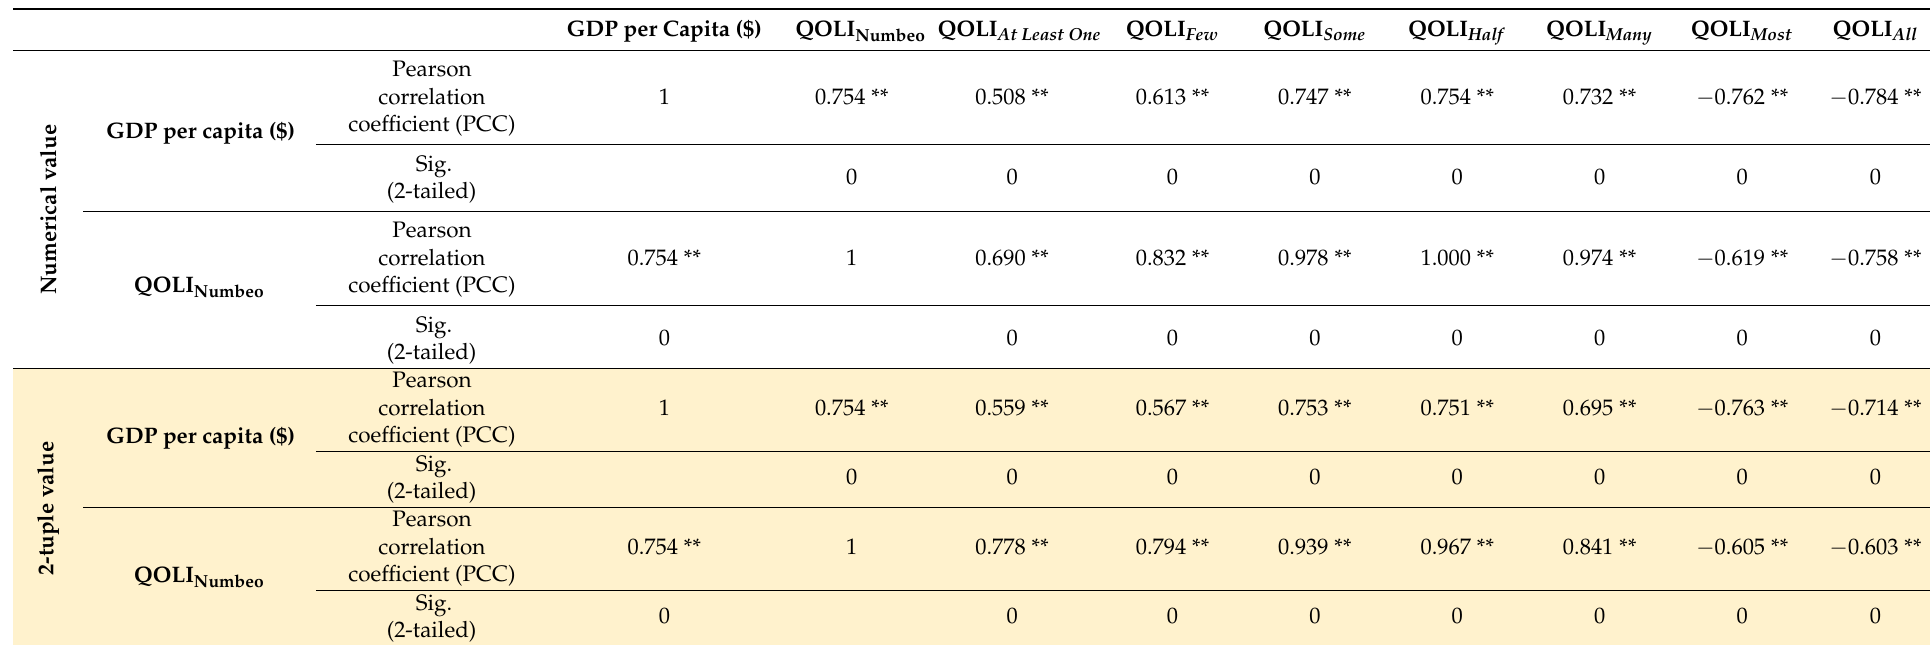
Table 15. Correlation analysis between the QOLI ranking and the GDP per capita ranking (number versus. 2-tuple